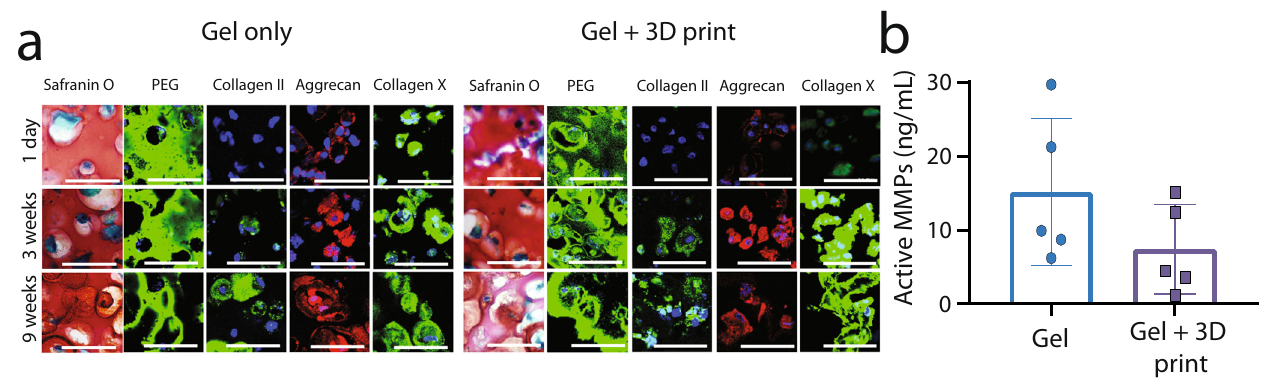
Fig. 5 3D printed growth plate mimetic composite supports MSC chondrogenesis. a Representative images from histological and immunohistochemical staining from paraf fi n-embedded samples for both the Gel only and Gel + 3D Print conditions after 1 day, 3 weeks, and 9 weeks of culture (scale bar = 50 µm). Due to dif fi culty in sectioning, the images for the gel + 3D print are at a closer magni fi cation than the gel only condition. Images include staining for PEG to assess hydrogel degradation, sGAGs (Safranin O/fast green), collagen II, and aggrecan to assess chondrogenic differentiation of encapsulated cells, and collagen X to assess hypertrophy. b Total matrix metalloproteinases (MMPs) secreted by the cells in the media over the course of the 9-week study. Data represent mean ± standard deviation (error